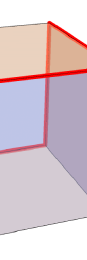
8. Surface hinge mode protected by inversion symmetry on a cubic geometry, assuming no other spatial symmetries are present. The mode is confined to the edges of the cube since the surface mass term cannot change on a flat